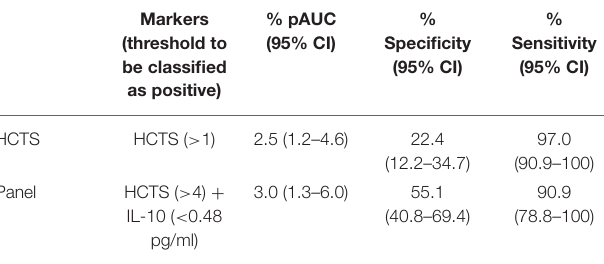
TABLE 5A | Ability of the Helsinki Computed Tomography Score alone and a panel consisting of the Helsinki Computed Tomography and interleukin 10 in distinguishing patients with unfavorable outcome from patients with favorable